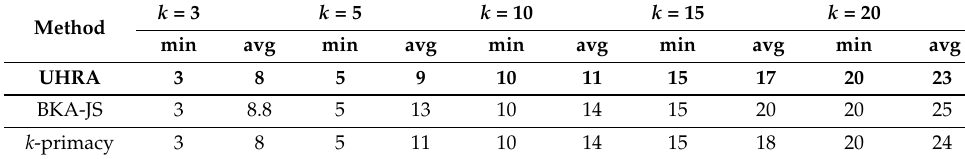
Table 3. The size (min, avg) of QI groups on the adult dataset with t = 0.5 and J = 0.8.